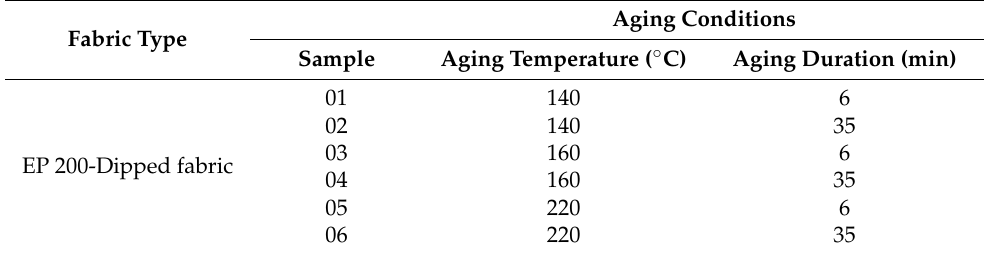
Table 2 . Thermal aging conditions of woven fabric samples. Table 2. Thermal aging conditions of woven fabric samples.